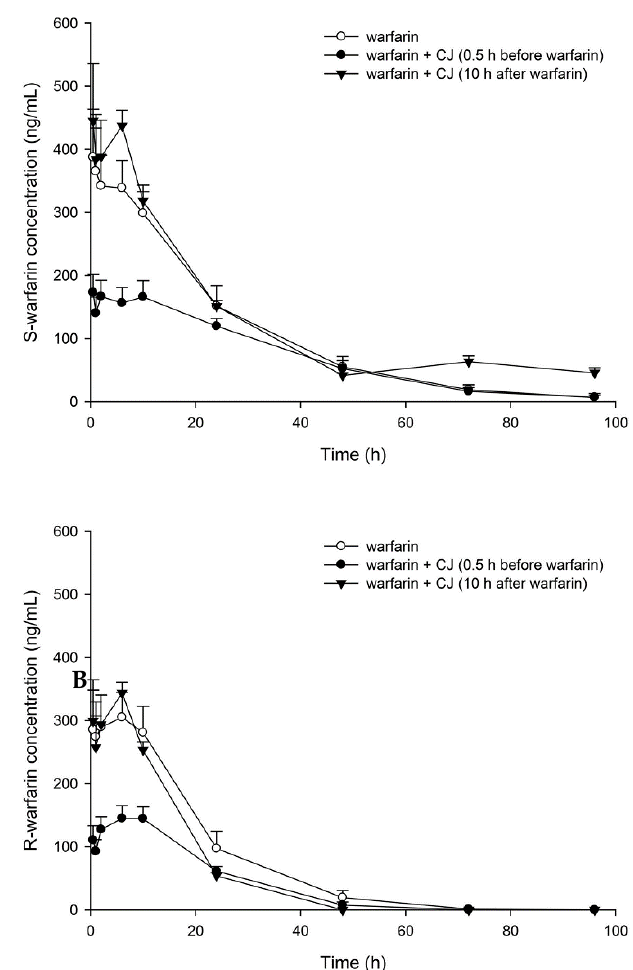
Figure 2. Mean ( ± S.E.) plasma concentration–time profiles of S-warfarin ( A ) and R-warfarin ( B ), after oral administration of ( ± ) warfarin (0.2 mg/kg) alone and coadministration with cranberry juice (CJ, 5.0 g/kg) at 0.5 h before and 10 h after (±) warfarin in rats. 3.3. Influence of CJ on the Anticoagulation Effect of Warfarin in Rats The mean INR-time profiles after oral administration of ( ± ) warfarin with and without CJ ingestion at 0.5 h before and 10 h after warfarin dosing are shown in Figure 3. The results indicate that when CJ was given 10 h later, the INR value at 24 h increased to 2.7 ±